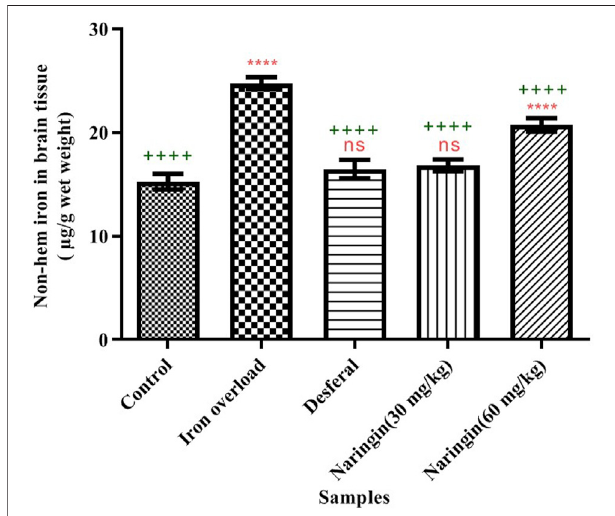
FIGURE 2 | Total nonheme iron content in the brain of different groups. Controlgroup:themiceweretreatedbynormalsaline;iron-overloadedgroup: the mice that were treated by iron dextran; DFO group: iron-overloaded mice that were treated by deferoxamine; naringin 30 mg/kg/day group: iron- overloaded mice that were treated by naringin 30 mg/kg/day; and naringin 60 mg/kg/day group: iron-overloaded mice that were treated by naringin 60 mg/kg/day (means ± SD). “ ++++ ” and “ ns ” indicate probability levels of 0.0001 and nonsigni fi cant, respectively. The stars indicate the probability levels in the same way. “ * ” shows the comparison of the mean of all groups with the control group. “ + ” shows the comparison of the mean of all groups with the iron-overloaded